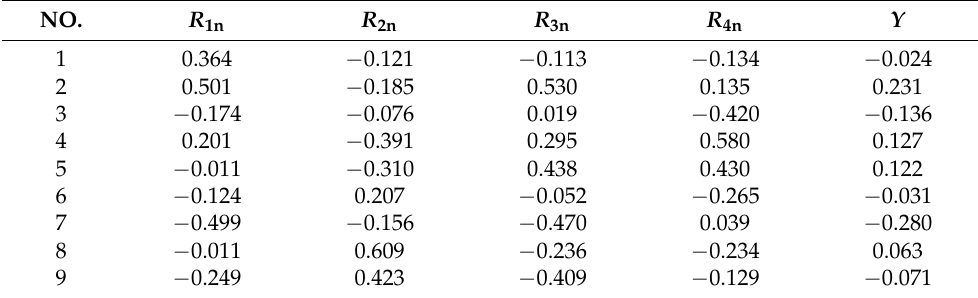
Table 5. The value of comprehensive evaluation.